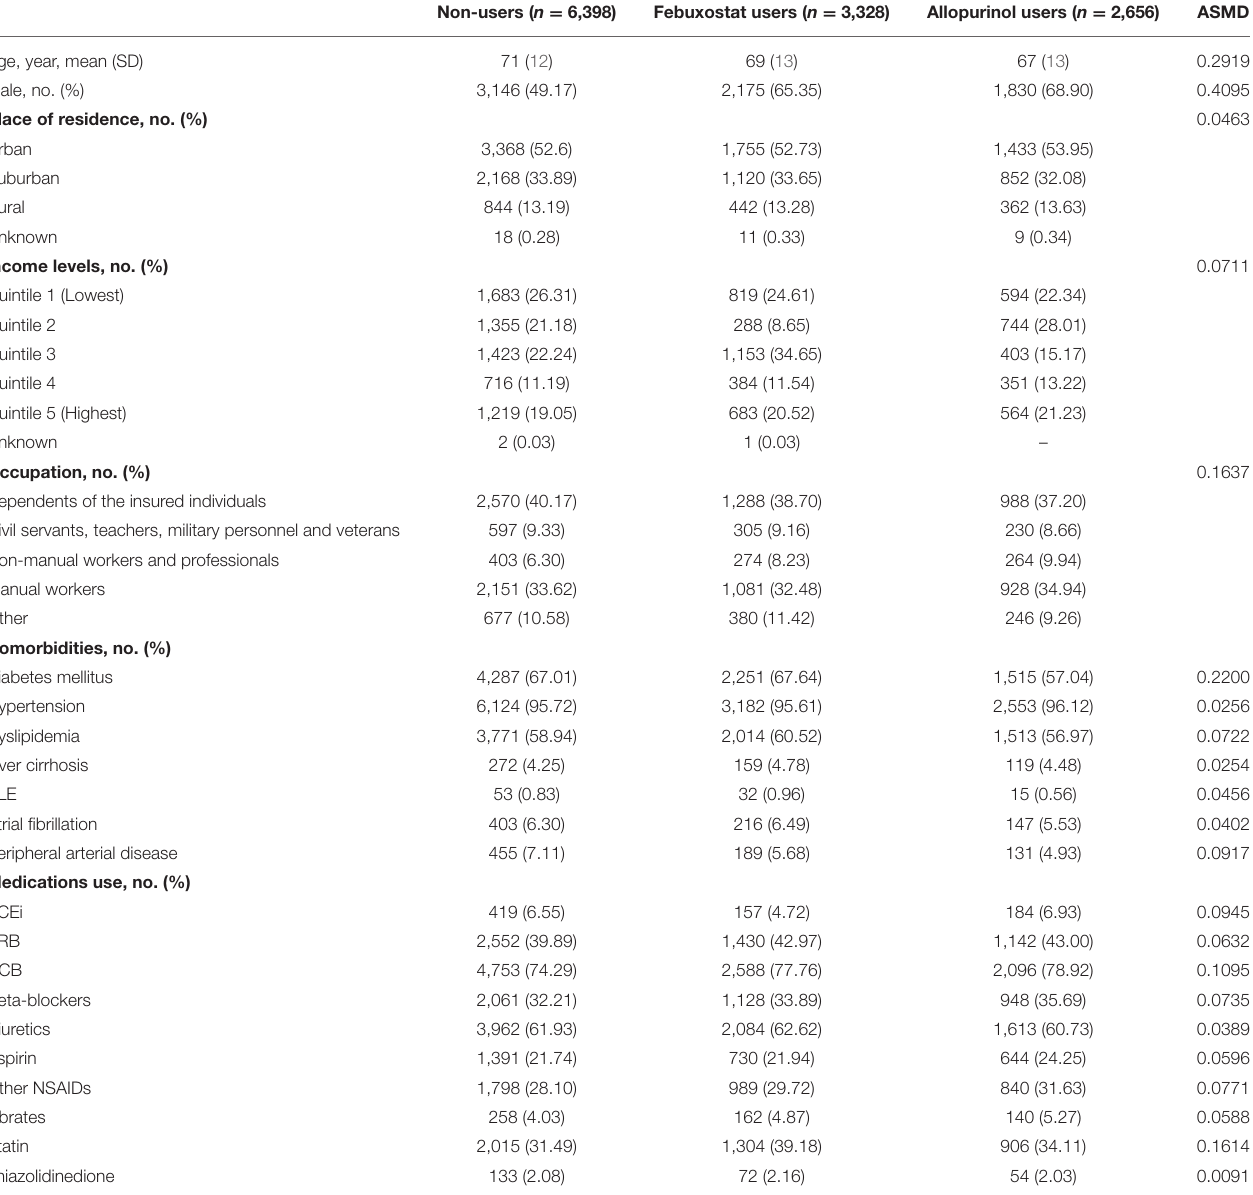
TABLE 1 | Baseline Patient Characteristics before Propensity Score